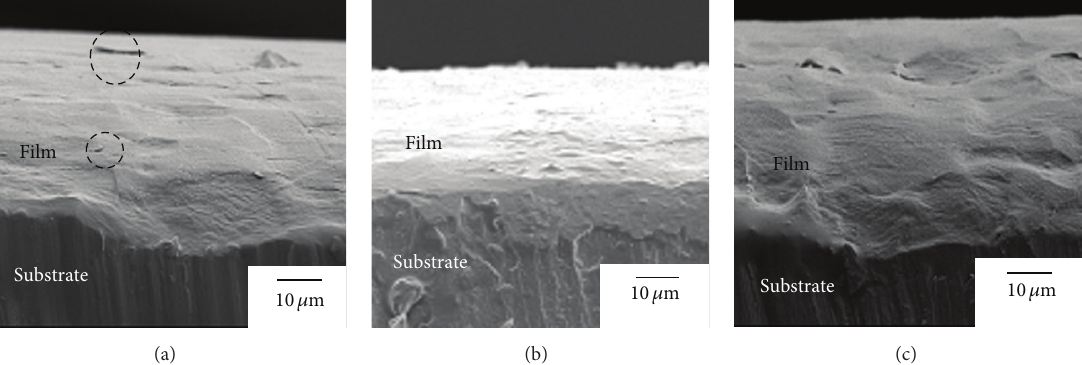
Figure 5: Cross-sectional SEM images of films deposited at various bias frequencies (10Hz, 1kHz, and 100 kHz), with bias voltage of 0.5 V and Y 2 O 3 concentration of 0.5 wt% in a suspension solution.